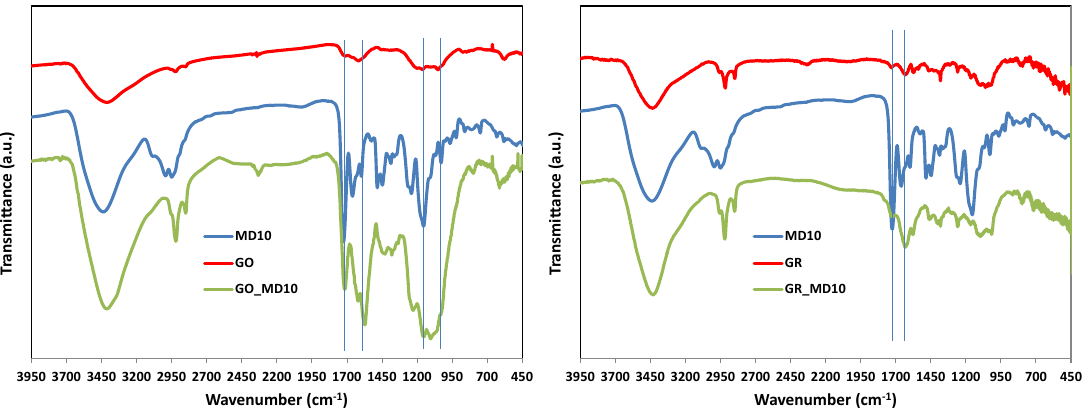
Figure 1. FTIR spectra of hybrid polymeric materials, GO, GR and MD10.